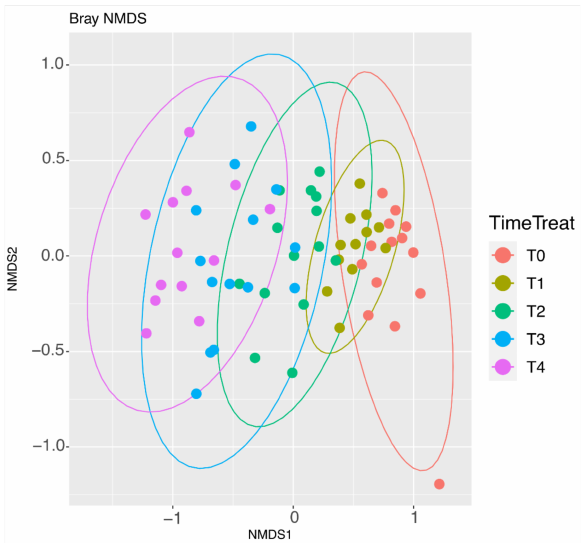
Figure 3. Non-metric multidimensional scaling (NMDS) at different time points (T0–T1–T2–T3–T4). Colors in the bidimensional NMDS plot are used according to the different sample origin as shown in the legend. The ordinate analysis is based on the Bray-Curtis distance matrix. The graphical plot and the ellipses were generated by ggplot2 R package implemented with stat ellipse function. (Number of animals: T1 n = 14, T2 n = 12, T3 n =14, and T4 n =13). Colors in the graphs are reported according to the different experimental times as shown in the figure